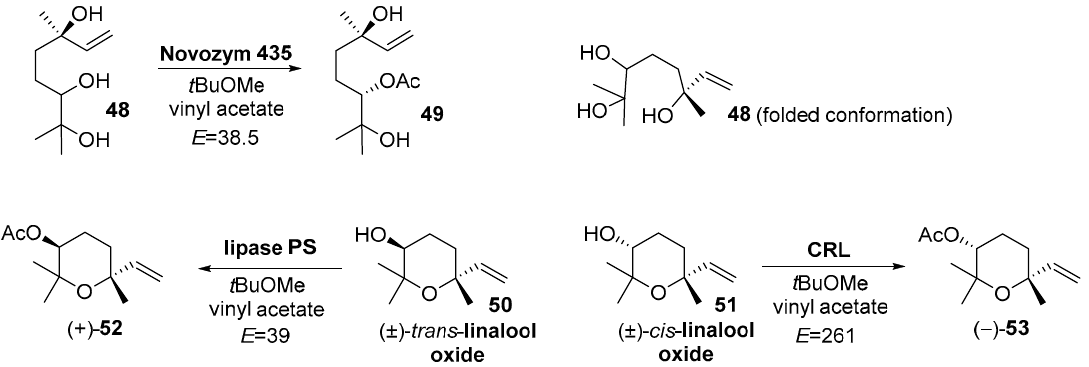
Figure 10. Lipase-mediated resolution of (6 R )-6,7-dihydroxylinalool ( 48 ) and of trans - and cis -linalool oxide 50 and 51 , respectively.